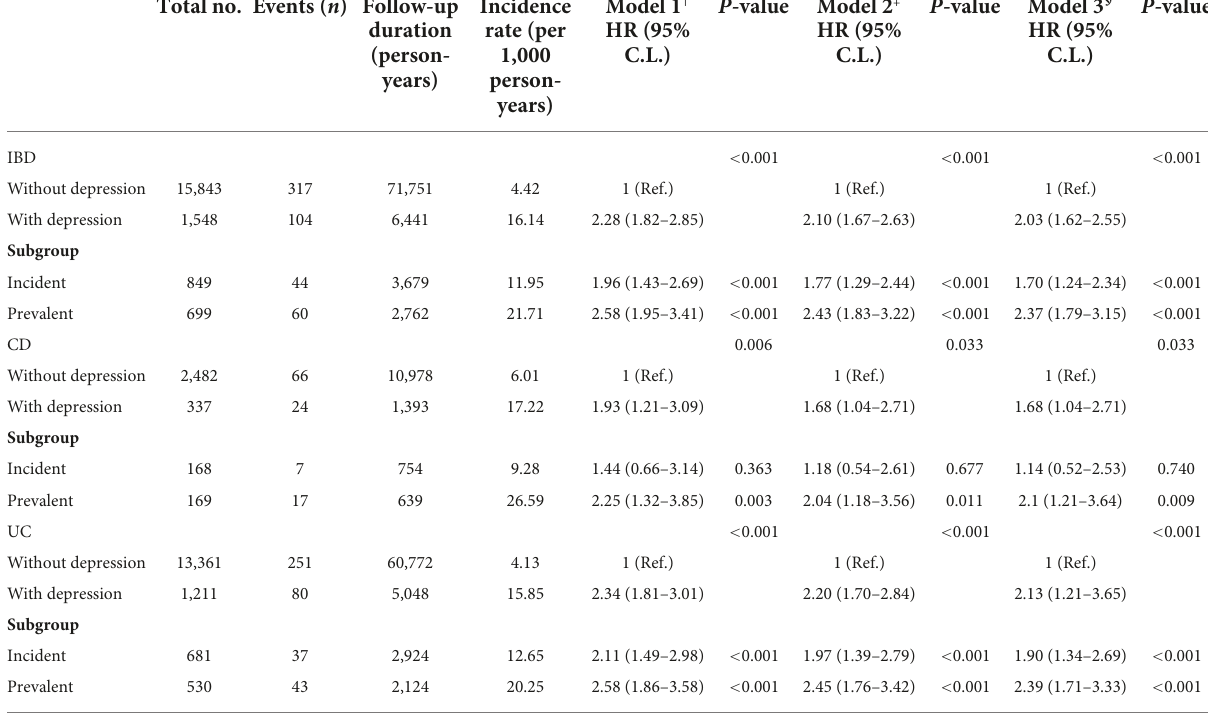
TABLE 3 Independent risk of dementia according to presence of depression in patients with inflammatory bowel disease (IBD).